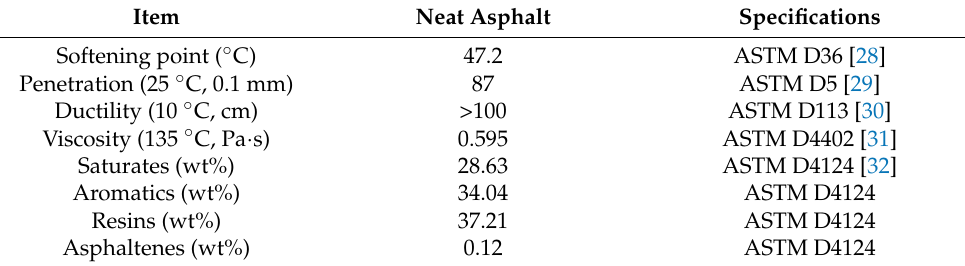
Table 1. Physical and chemical properties of neat asphalt.